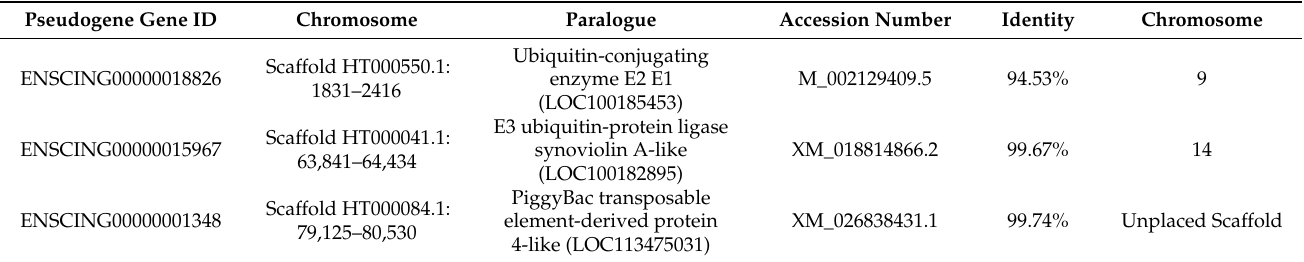
Table 4. Pseudogene identified by next-generation sequencing (NGS) and annotated by Ensembl database. Pseudogene Gene ID